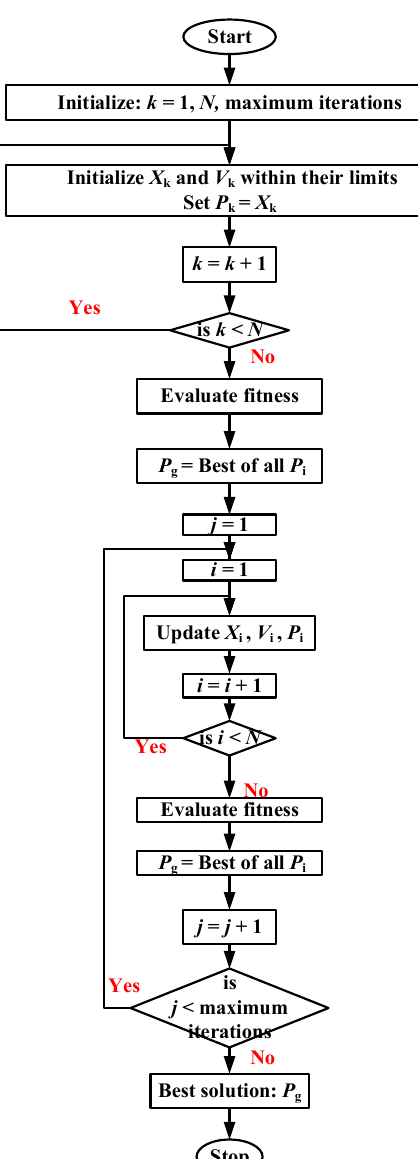
Figure 1. Standard PSO algorithm.